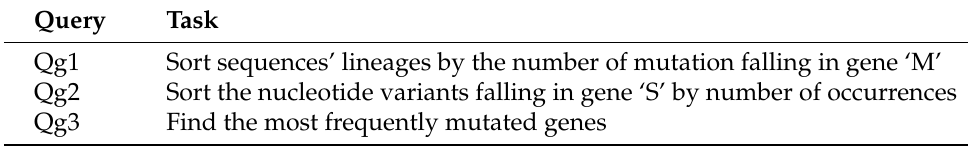
Table 2. Examples of queries optimized by the materialized view N UCLEOTIDE V ARIANT A NNOTATED ; the view’s definition implements the join operation between the table N UCLEOTIDE V ARIANT , and the attribute gene_name from table A NNOTATION offline.